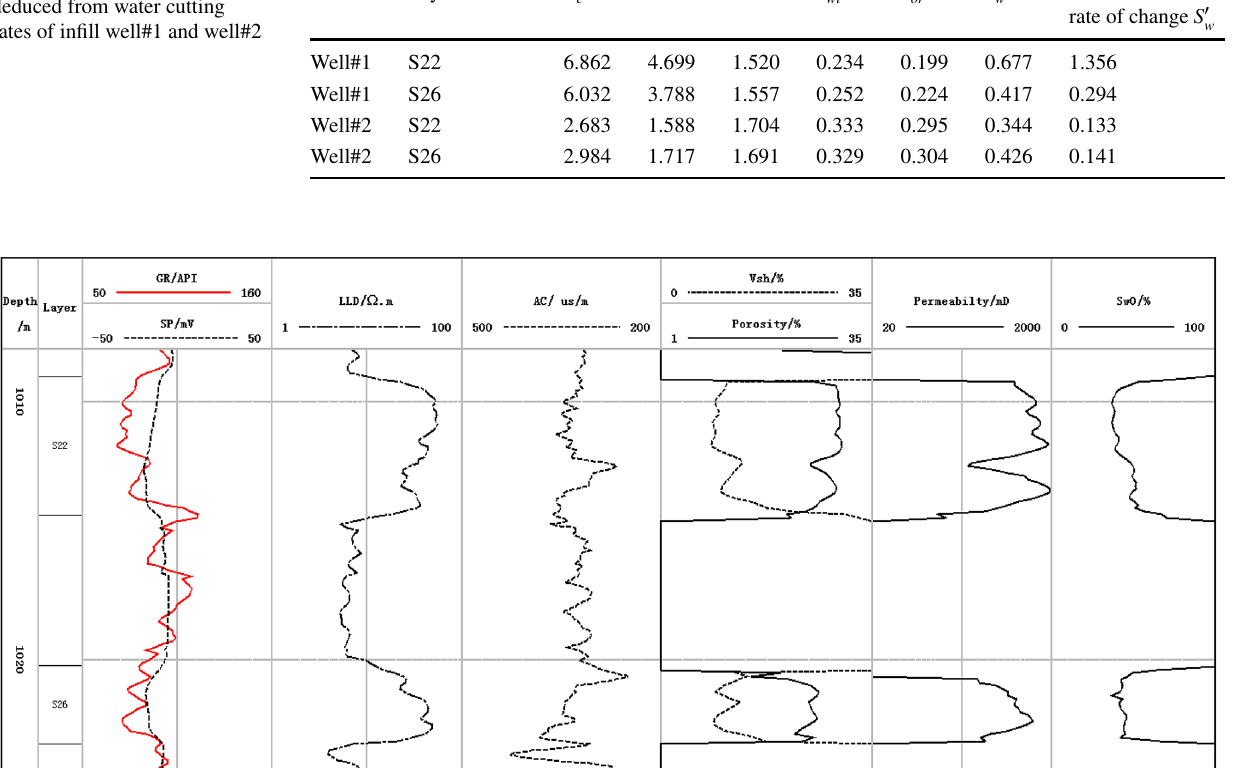
Table 7 The relative parameters deduced from water cutting rates of infill well#1 and well#2